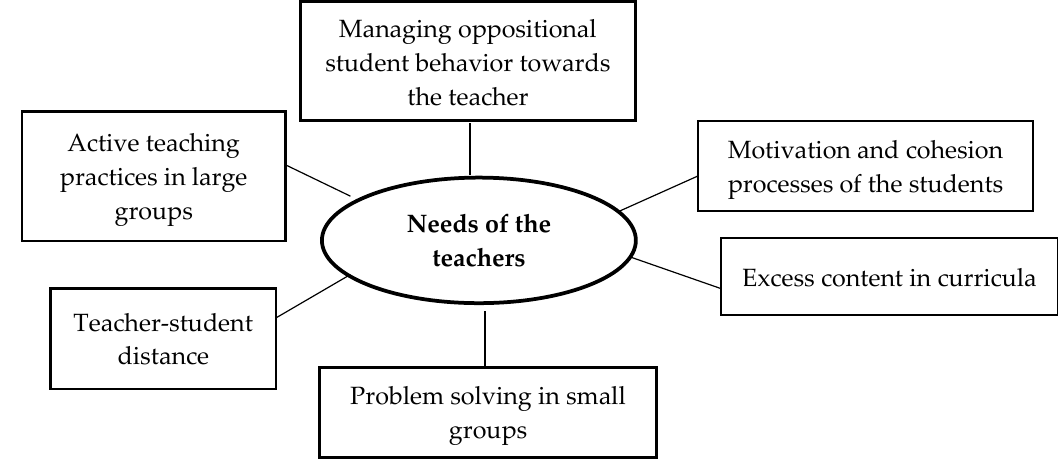
Figure 2. Perceived needs of university teachers.